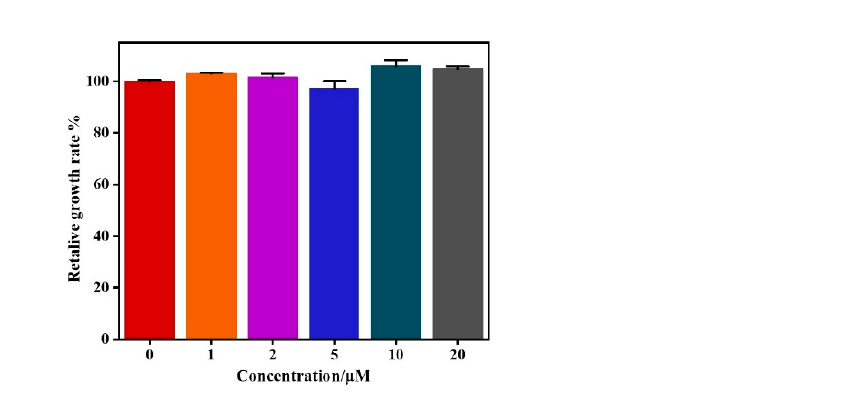
Figure 4. Relative growth rate (%) of cells that were cultured in the presence of a 0 to 20 µ M probe CMB for 24 h and estimated by the CCK8 assay.